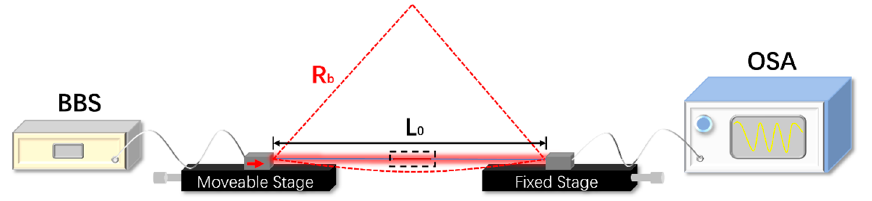
Figure 4. Schematic diagram of the experimental setup of the HCBF-based sensor for curvature measurement.